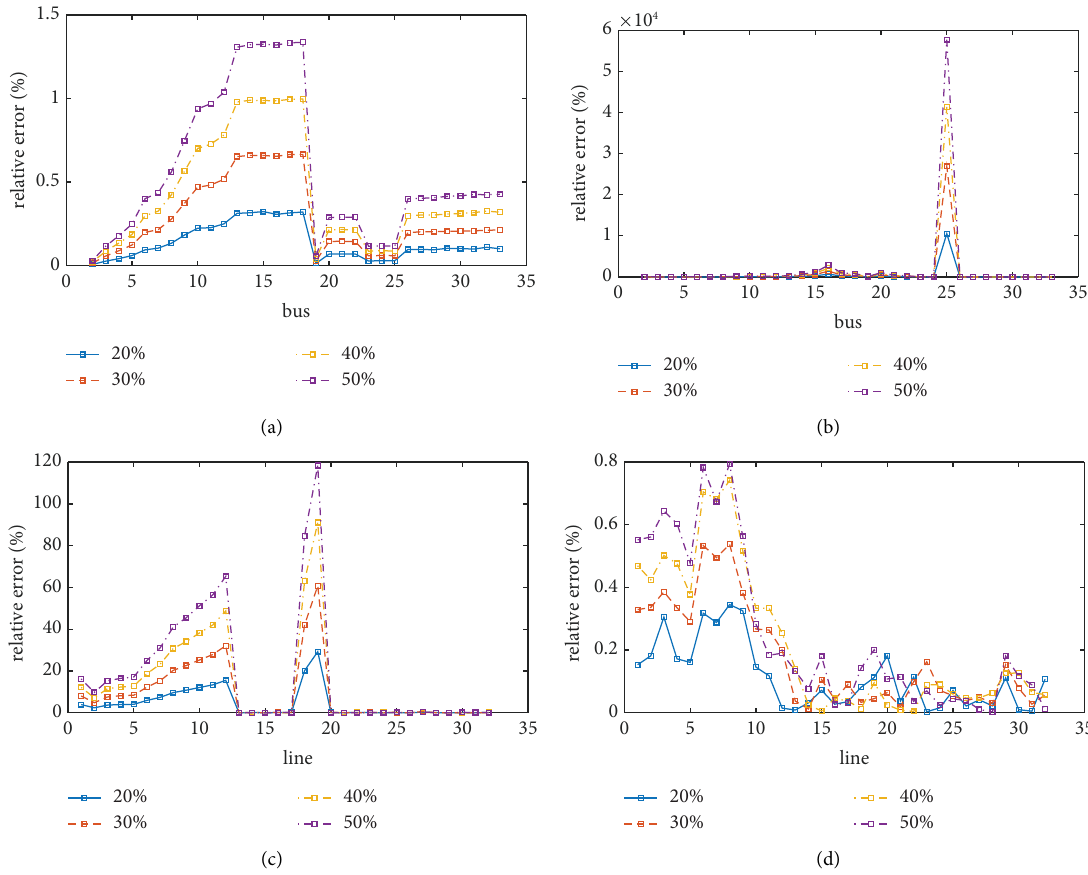
Figure 9: Te value of X with diferent penetrations of WT. (a) V m . (b) V a . (c) P line . (d) Q line ∗